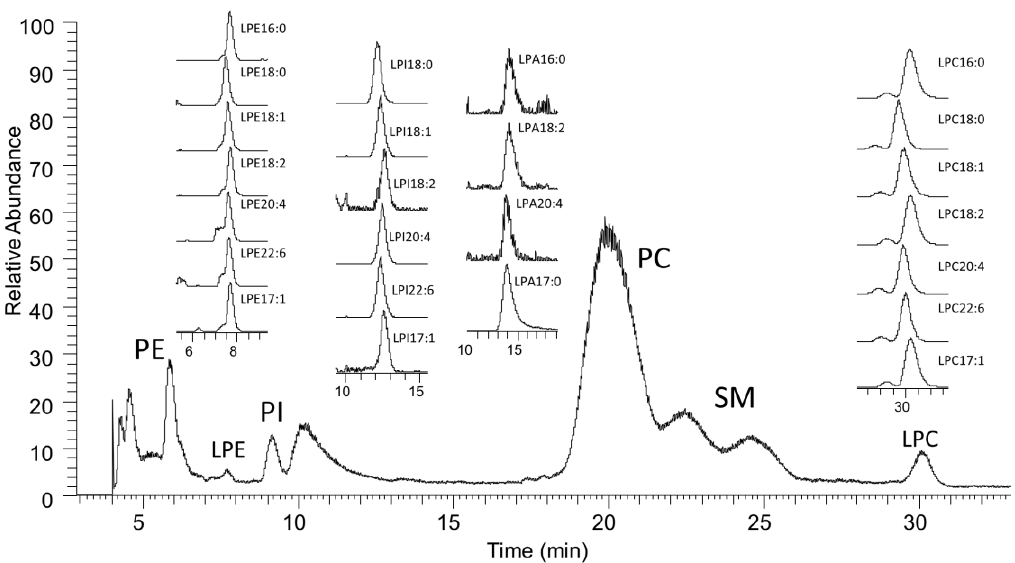
Figure 1. Ion chromatogram of HPLC-MS analysis. The extracted ion chromatograms of individual species of lysophosphatidylethanolamine (LPE), lysophosphatidylinositol (LPI), lysophosphatidic acid (LPA), and lysophosphatidylcholine (LPC) were generated using the corresponding molecular weights at the given retention times compared to standard lysophospholipids.